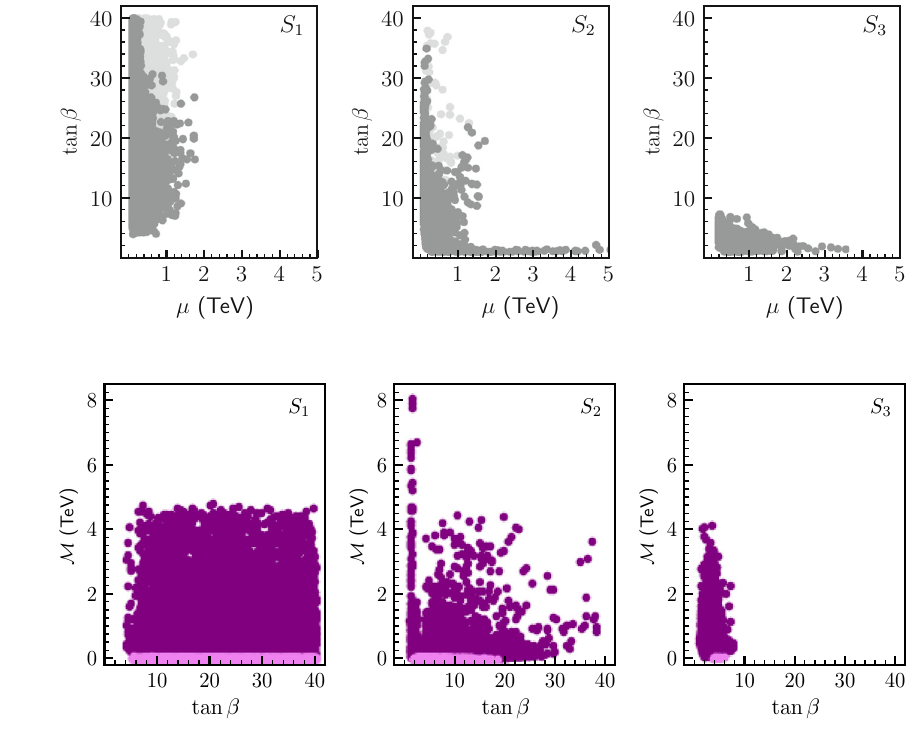
16 . 96 × 10 − 10 , 16 . 83 × 10 − 10 , and 3 . 7 × 10 − 10 , respec- tively. Thus, although none of the points of the parameter space is compatible at 1 σ with (cid:9) a μ in some regions a SUSY μ is compatible at 2 σ . Note that we are neglecting the uncer- tainties in the SUSY computation. The result is shown in Fig. 3. The largest contributions to a SUSY μ are found for small μ and large tan β . In our scenarios, since bino- and wino- like (neutralino or chargino) eigenstates are heavy (in our scans M 2 = 2 M 1 = 1800 GeV) the contributions involv- ing them are suppressed. Besides, although the Higgsino-like eigenstates can be light when μ is relatively small, their con-